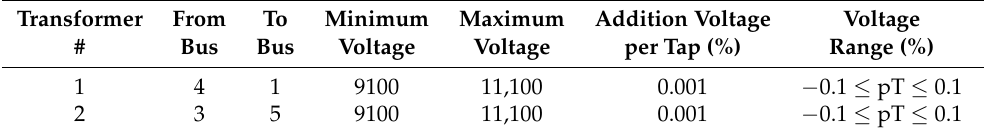
Table 2. Characterization of transformers in the IEEE 6-bus test system. Transformer